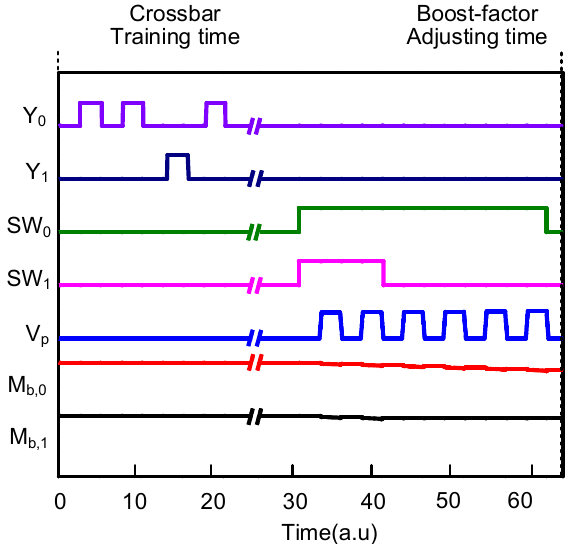
Figure 7. The simulated waveforms of the proposed memristor-CMOS hybrid circuit with the boost-factor adjustment.